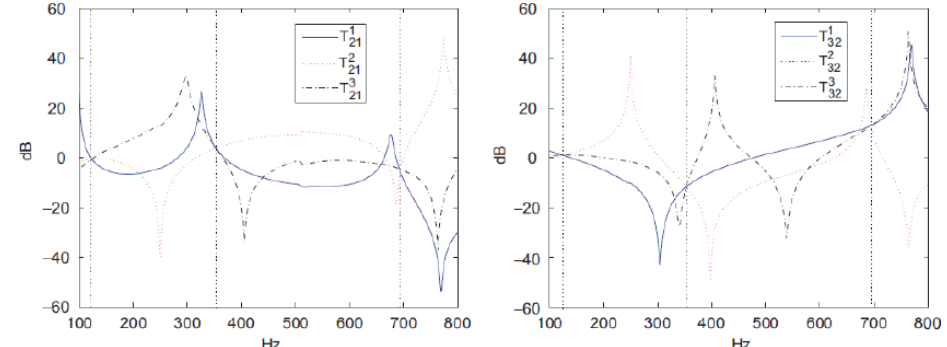
Figure 15. Transmissibility functions for three different loading conditions T k , for outputs 1 and 2 (left) and outputs 2 and 3 (right). The systems poles lie at the intersection of the functions indicated by vertical dashed lines (Devriendt and Guillaume,